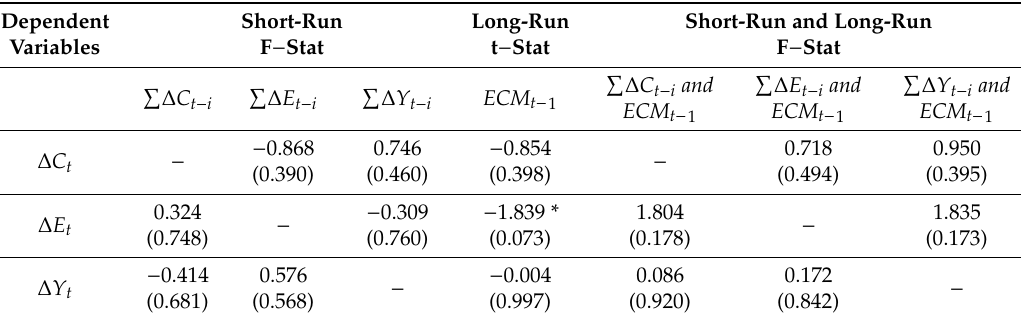
Table 6. Causality results